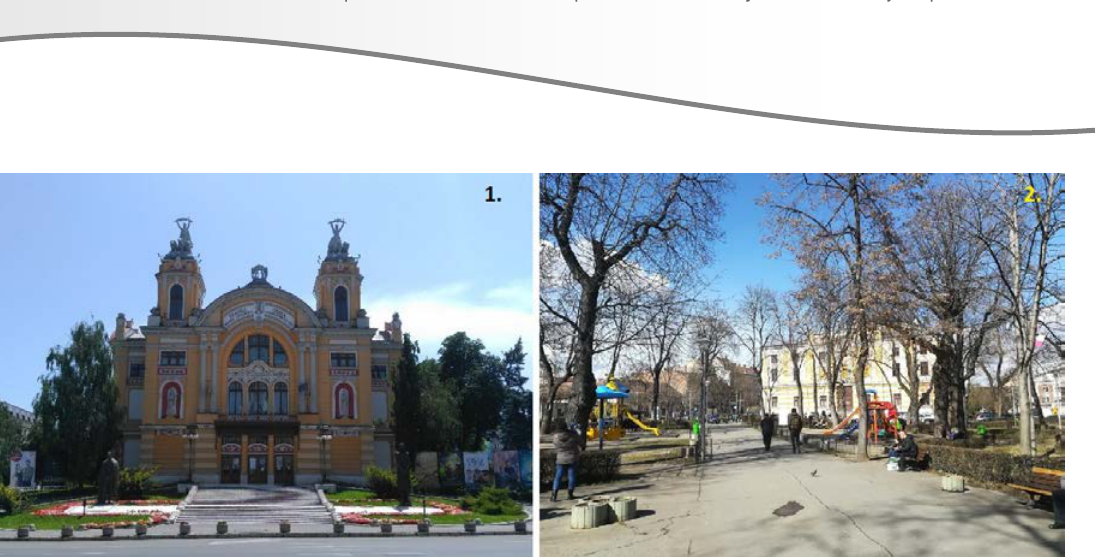
Figure 9: “Lucian Blaga ” National Theatre and the Romanian Opera. 1 - Front side; 2 - Back side Source: 1 - Emanuel- Cristian ADOREAN, 2016© and 2 - Alexandru- Sabin NICULA,